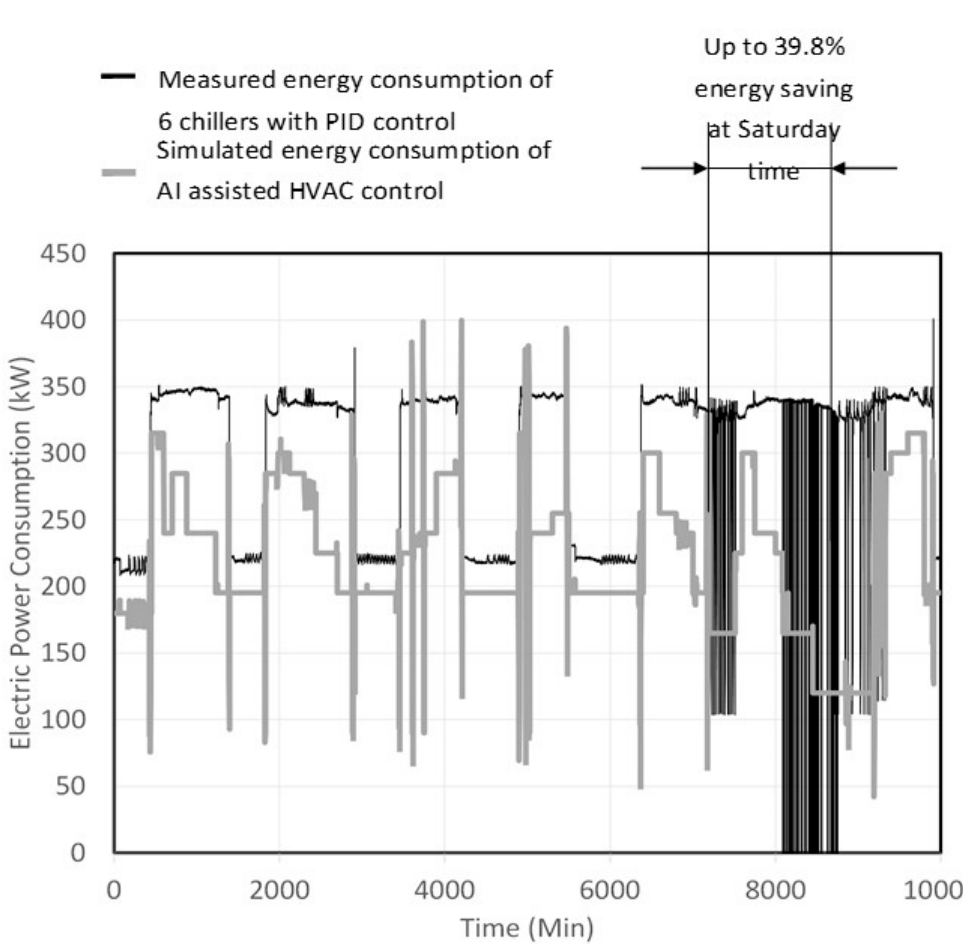
Figure 7. The energy savings of the AI-assisted control on the hottest week of 2017.